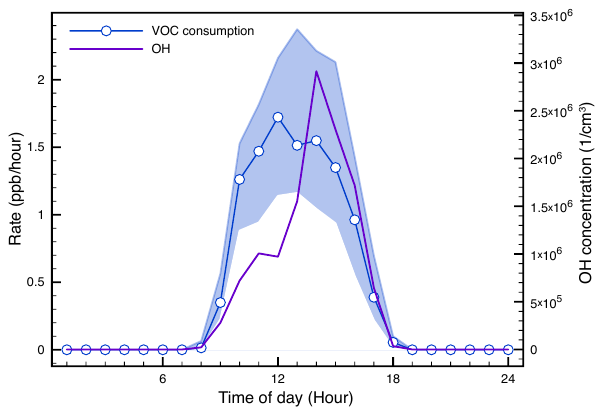
Figure 5. The production rate and concentration change of n -propyl nitrate calculated from field observations. The difference between the red and blue traces represents the mixing loss promoted by solar surface heating. The green trace is the calculated effective first-order mixing rate, k mix . The red shaded area represents the in- terquartile (25–75%) coverage for n -propyl nitrate formation.